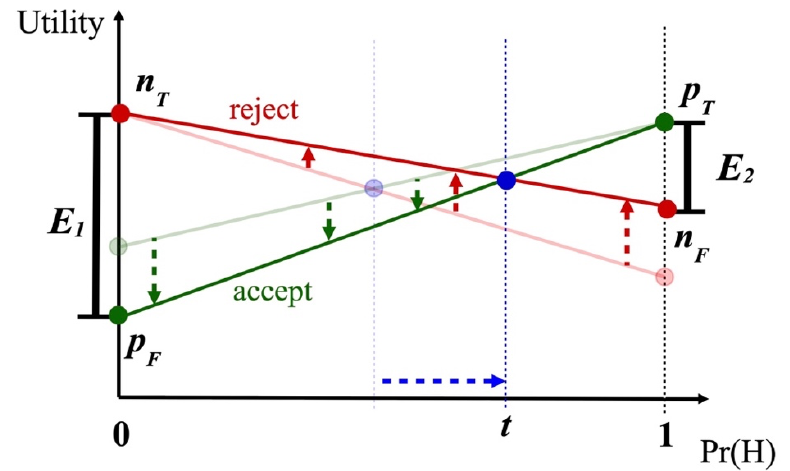
Figure 4. Appropriately raising evidential standards in view of the non-epistemic costs or benefits of error: when costs or benefits are tied to error strictly as such, the AIR applies. For example, if H is “Hydroxychloroquine (HCQ) is a safe/effective treatment for Covid-19,” many costs of endorsing HCQ when it is in fact unsafe or ineffective are valid reasons to raise the evidential bar for H. Unsafe drugs cause harms that safe drugs do not, and endorsing ineffective drugs diverts focus from effective treatments in a way that endorsing effective drugs does not. So, these are costs of false positives strictly as errors, not simply as instances of accepting a claim that happens to be false. Relevant costs/benefits are anchored to the truth or falsity of the hypothesis at